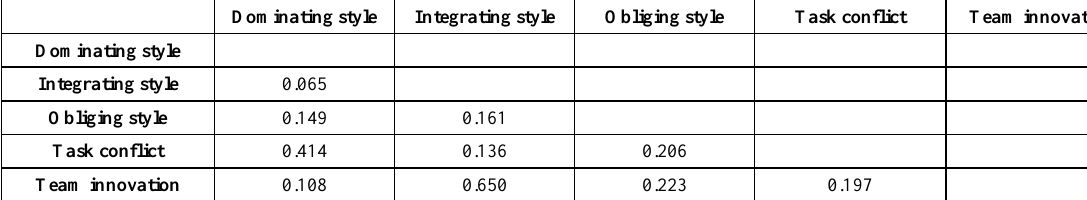
Table 3. HTMT ratio